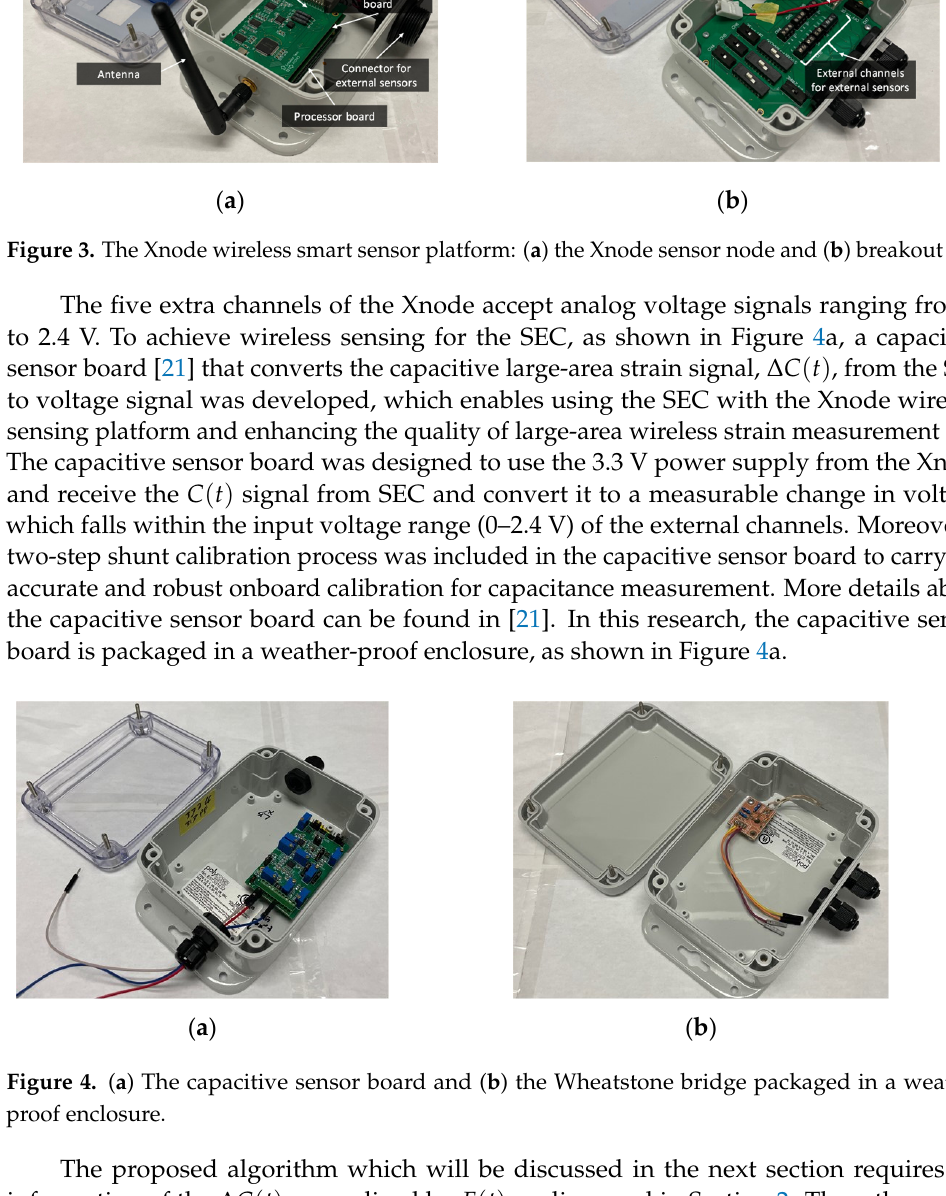
Figure 3. The Xnode wireless smart sensor platform: ( a ) the Xnode sensor node and ( b ) breakout box .